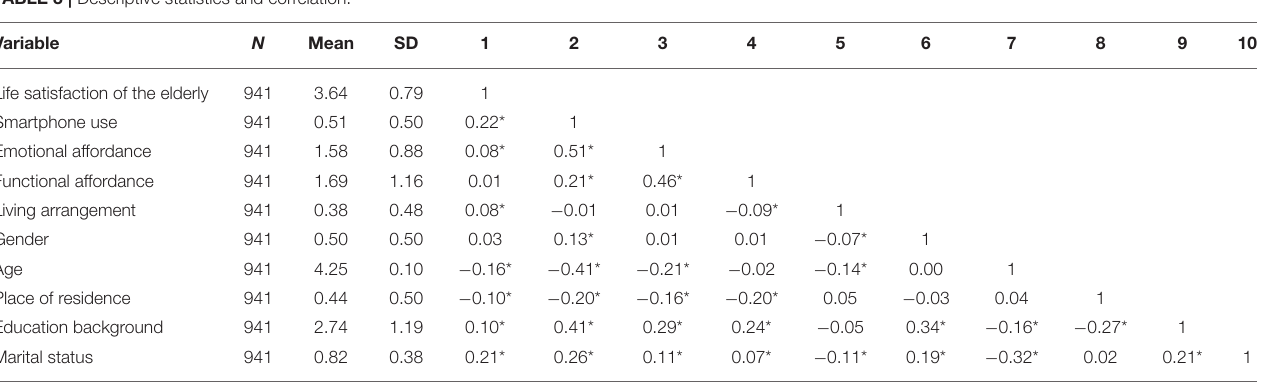
TABLE 3 | Descriptive statistics and